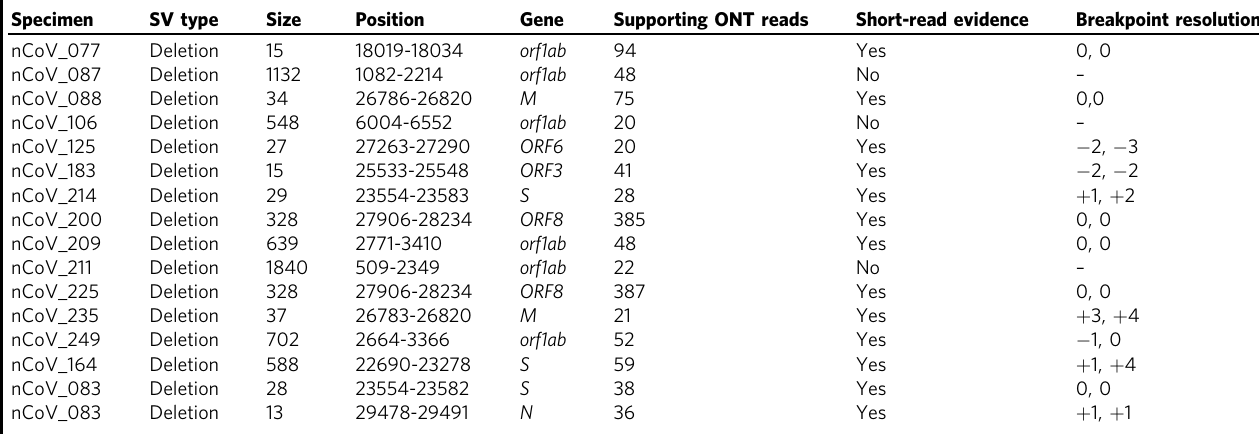
Table 3 Detection of structural variation in SARS-CoV-2 specimens with ONT sequencing.